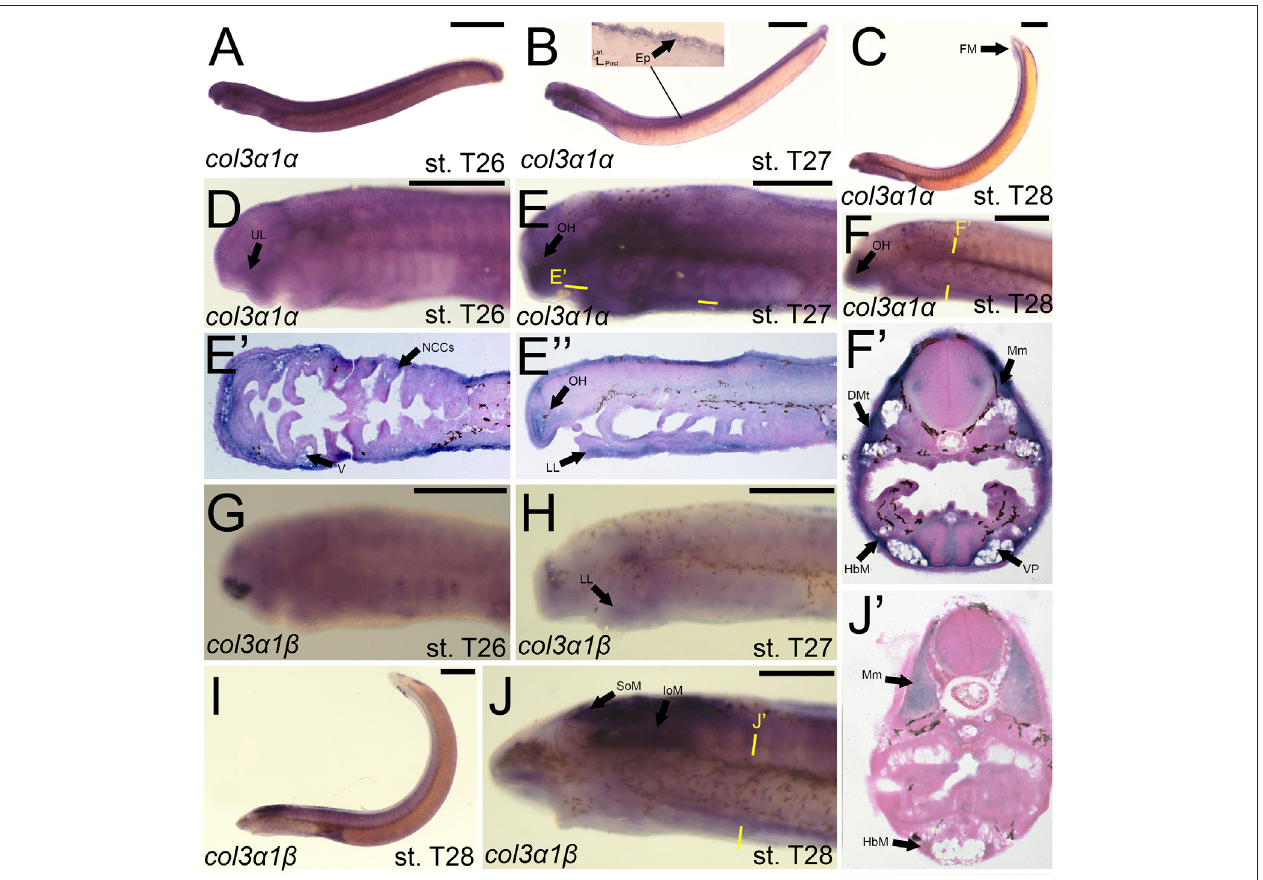
FIGURE7| Expressionof colA6/col3a1 α and colA4/col3a1 β inlarvallamprey.Allscalebarsareapproximately500 μ m. (A,D) col3a1 α expressionwasinthecranial ganglia as well as the mesenchyme of the upper lip. (B,E) col3a1 α expression was in the mesenchyme of the oral hood, lower lip, ventral pharynx, and velum, the non- skeletogenicneuralcrestcellsofthepharynx,aswellastheepidermis. (C,F) col3a1 α expressionwasinthemesenchymeoftheoralhood,lowerlip,andventralpharynx, themyomeres,hypobranchialmusculature,andthedermomyotome. (G) col3a1 β expression wasintherostralheadinanunknowntissue. (H) col3a1 β expression wasin the forebrain and themesenchyme ofthe lower lip. (I,J) col3a1 β expression was in the infraoptic and supraoptic muscle populations as well as thehypobranchial musculatureandmyomeres.Keywords:DMt:dermomyotomeEp:epidermis;FM: fi nmesenchyme;HbM:hypobranchialmusculature;IoM:infraopticmuscles;LL:lower lip; Mm: myomeres; NCCs: neural crest cells; OH: oral hood; SoM: supraoptic muscles; UL: upper lip; V: velum; VP; ventral pharynx.